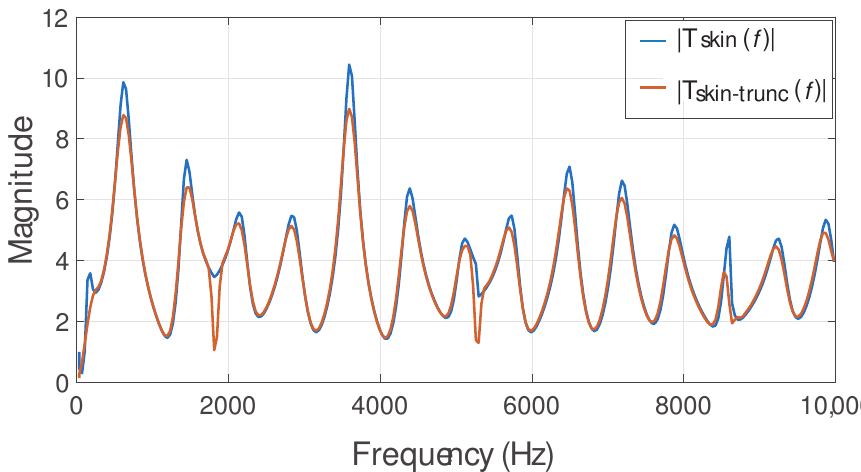
Figure 8. Neck-skin frequency response for a healthy female subject, full length (blue) and truncated version with a Hann window (red).